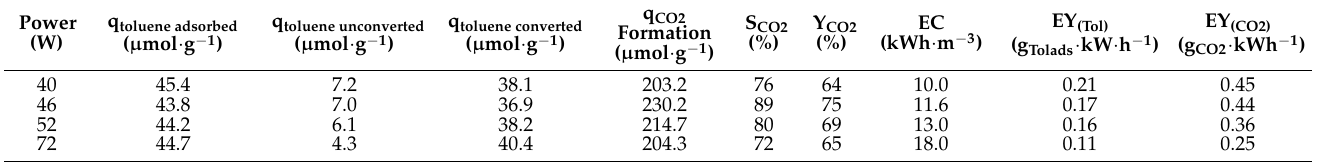
Table 3. Performances of the APC process as a function of NTP